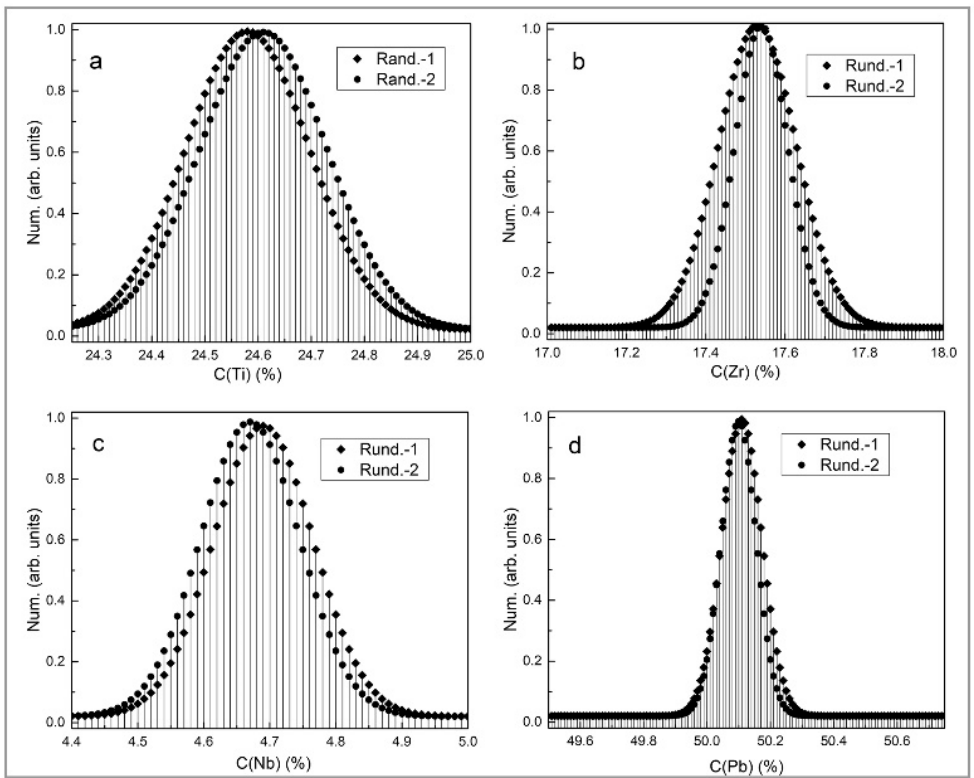
Figure 6. The concentration distributions for two samples (Rand-1, Rand-2) obtained by fluorescence excitation of the characteristic radiation by the surface of the analyzed ceramic sample (CCT3).